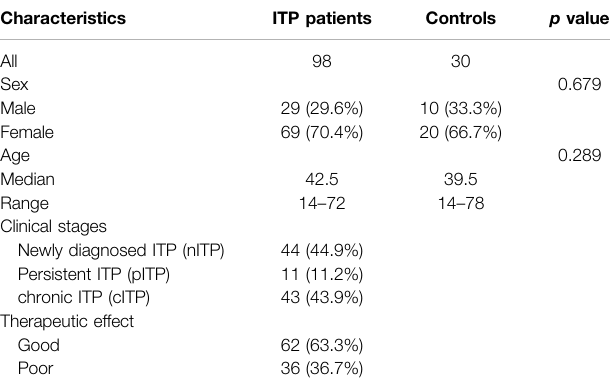
TABLE 1 | Clinical characteristics of the study participants.